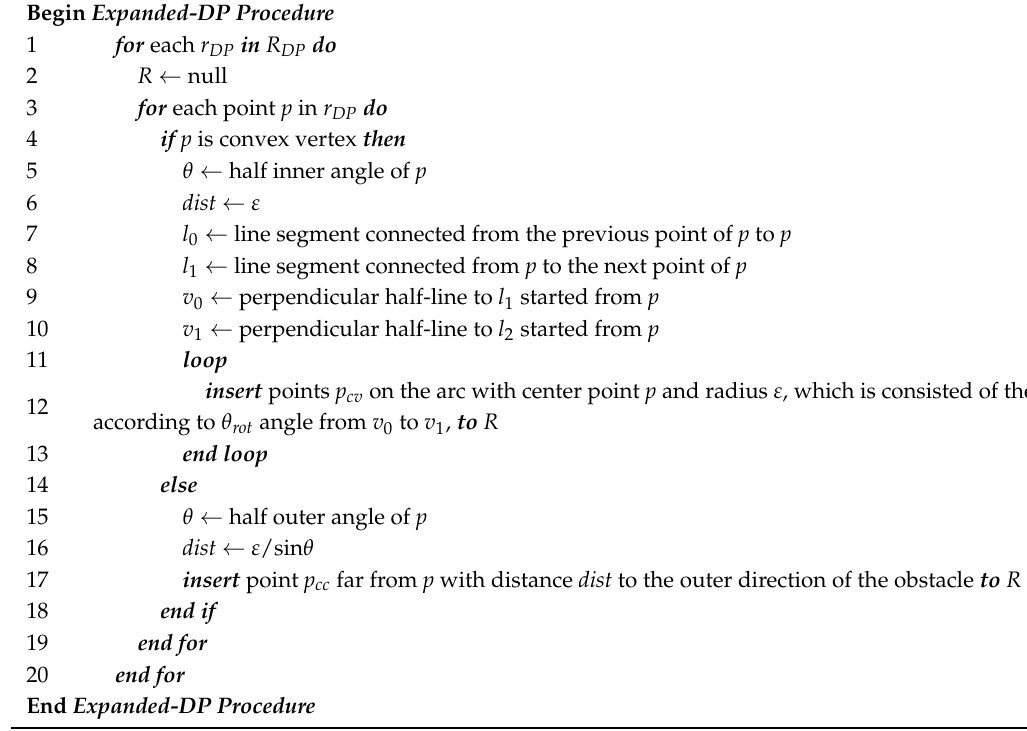
Algorithm 4. Pseudo Code of EDP (Detailed version).